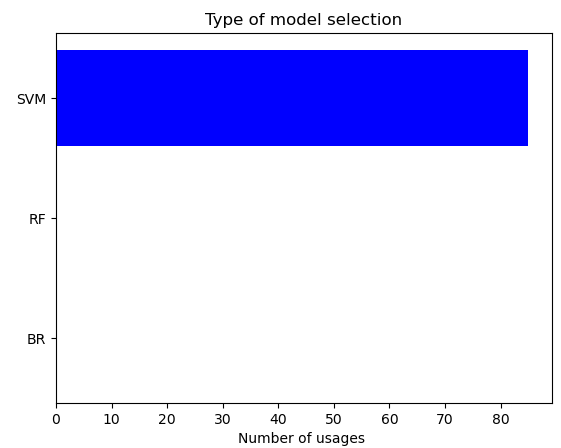
Figure 12. Type of model selection for the nonlinear